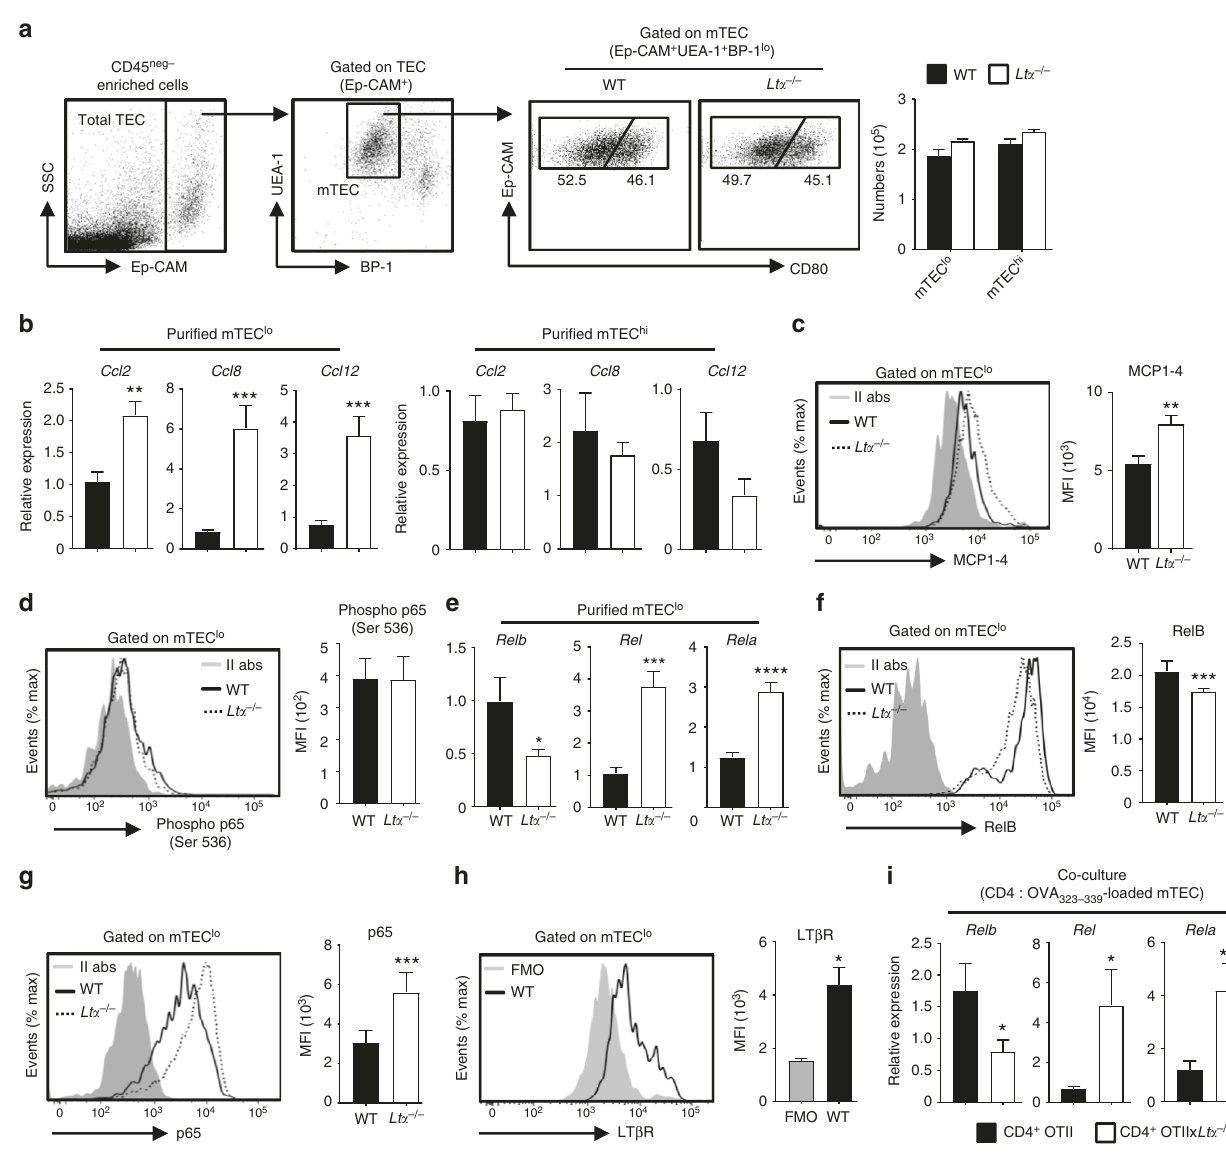
Fig. 5 Upregulation of CCL2, CCL8 and CCL12 chemokines, speci fi cally in Lt α − / − mTEC lo , correlates with the upregulation of classical NF- κ B subunits. a Gating strategy and fl ow cytometry pro fi les used to analyse total mTECs (CD45 - Ep-CAM + BP-1 lo UEA-1 + ), mTEC lo (CD45 − Ep-CAM + BP-1 lo UEA-1 + CD80 lo ) and mTEC hi (CD45 − Ep-CAM + BP-1 lo UEA-1 + CD80 hi ) in WT and Lt α − / − mice. This gating strategy was used to sort and analyse mTECs in Figs. 3 and 5. The histogram shows numbers of mTEC lo and mTEC hi cells in both mice. b Ccl2, ccl8 and ccl12 mRNAs were measured by qPCR in puri fi ed mTEC lo and mTEC hi from WT ( n = 8) and Lt α − / − ( n = 8) mice. c , d MCP1 – 4 ( c ) and phosphorylation of Ser536 p65 ( d ) were analysed by fl ow cytometry in mTEC lo from WT and Lt α − / − mice. Histograms show the MFI of MCP1 – 4 and phospho p65 (Ser536). e Relb, Rel and Rela mRNAs were measured by qPCR in puri fi ed mTEC lo from WT ( n = 8) and Lt α − / − ( n = 8) mice. f , g RelB ( f ) and p65 ( g ) protein levels were analysed by fl ow cytometry in mTEC lo from WT and Lt α − / − mice. Histograms show the MFI of RelB and p65 expression. h LT β R expression was analysed by fl ow cytometry in WT mTEC lo . The histogram shows the MFI of LT β R. i Relb, Rel and Rela mRNAs were measured by qPCR in mTECs loaded ( n = 6) or not ( n = 6) with OVA 323 – 339 peptide co-cultured with CD4 + thymocytes from OTII- Rag2 − / − mice or OTII- Rag2 − / − x Lt α − / − mice. a – i Data are representative of two independent experiments ( n = 3-4 mice per group and per experiment). II abs secondary antibodies, FMO fl uorescence minus one, MFI mean fl uorescence intensity. Error bars show mean ± SEM, * p < 0.05, ** p < 0.01, *** p < 0.001, **** p < 0.0001 using one-tailed Mann – Whitney test for c , f , g , two-tailed Mann – Whitney test for h and